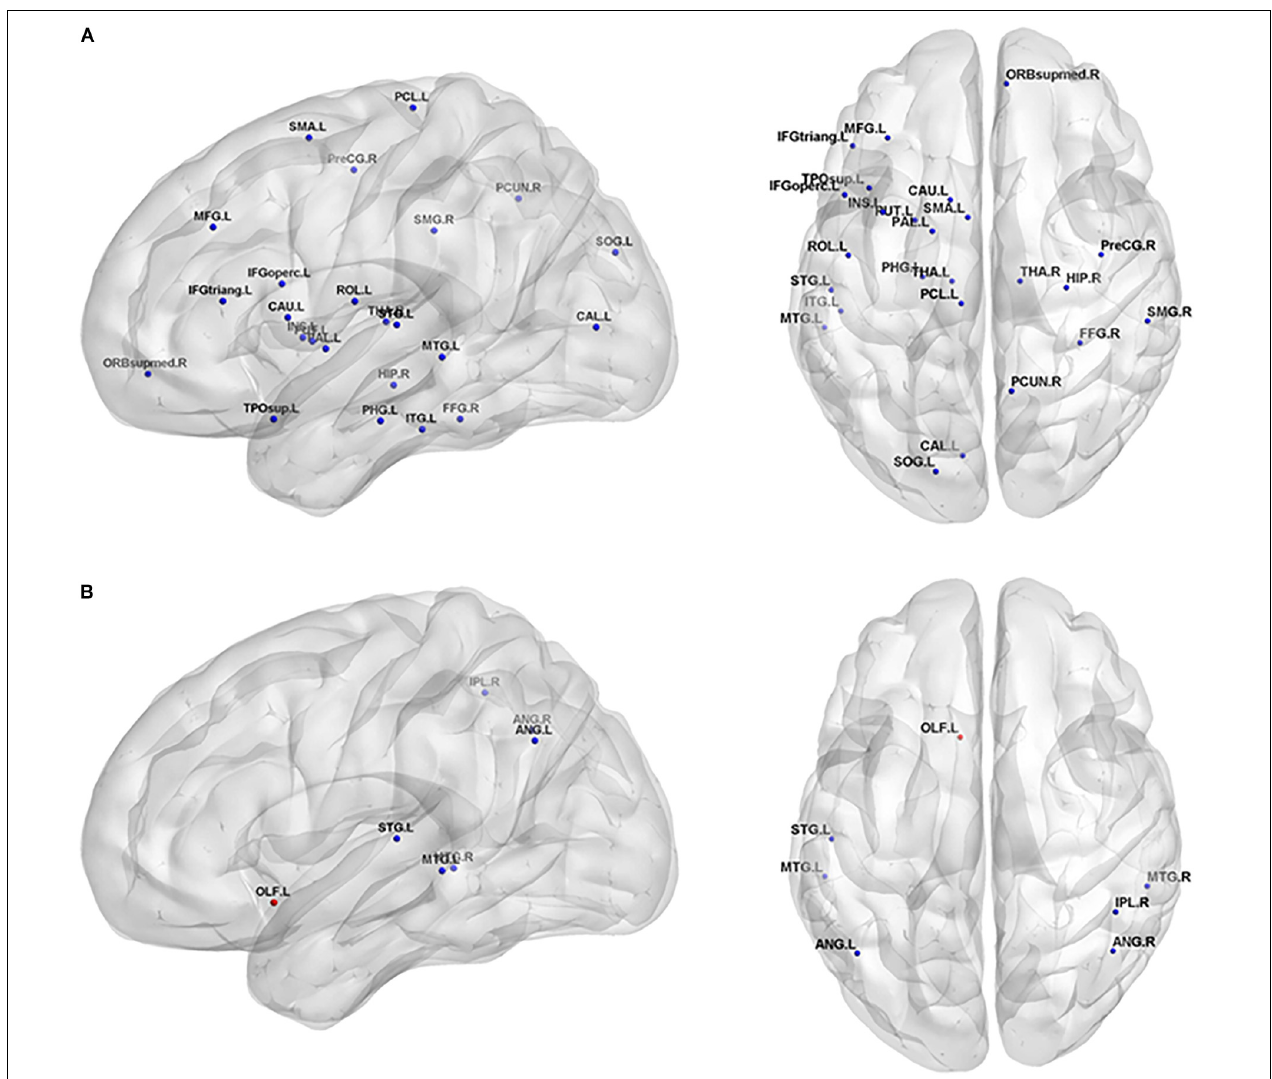
FIGURE 3 | Brain regions show significant alterations of nodal efficiency in SIVCIND patients compared with normal controls ( p < 0.05, FDR-corrected). The results were visualized using BrainNet Viewer (NKLCNL, Beijing Normal University). Three-dimensional maps show the significant differences in nodal global efficiency (A) and nodal local efficiency (B) between the SIVCIND patients and normal controls. Red/blue spheres denote regions where nodal efficiency are increased/decreased in SIVCIND patients. Detailed brain region information corresponding to the anatomical labels can be found in